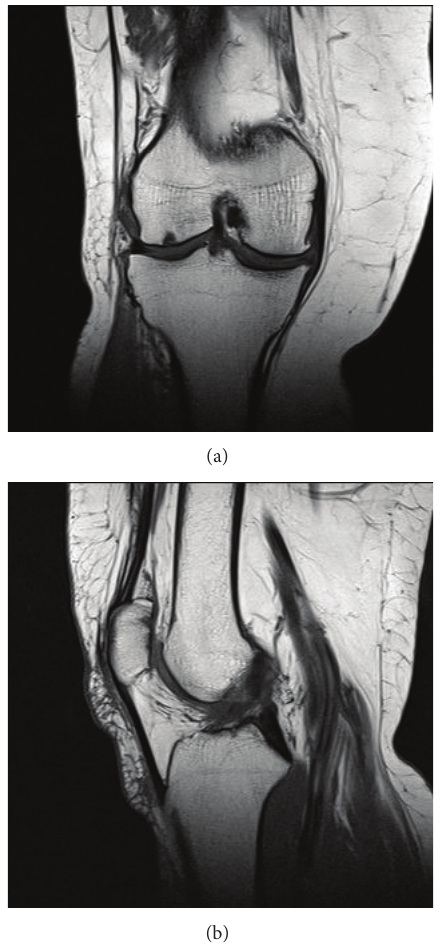
Figure 1: Preoperative T1-weighted MR image of the right knee, revealing complete tear of the medial meniscus, degeneration of the tibiofemoral joint cartilage, and chondromalacia of the